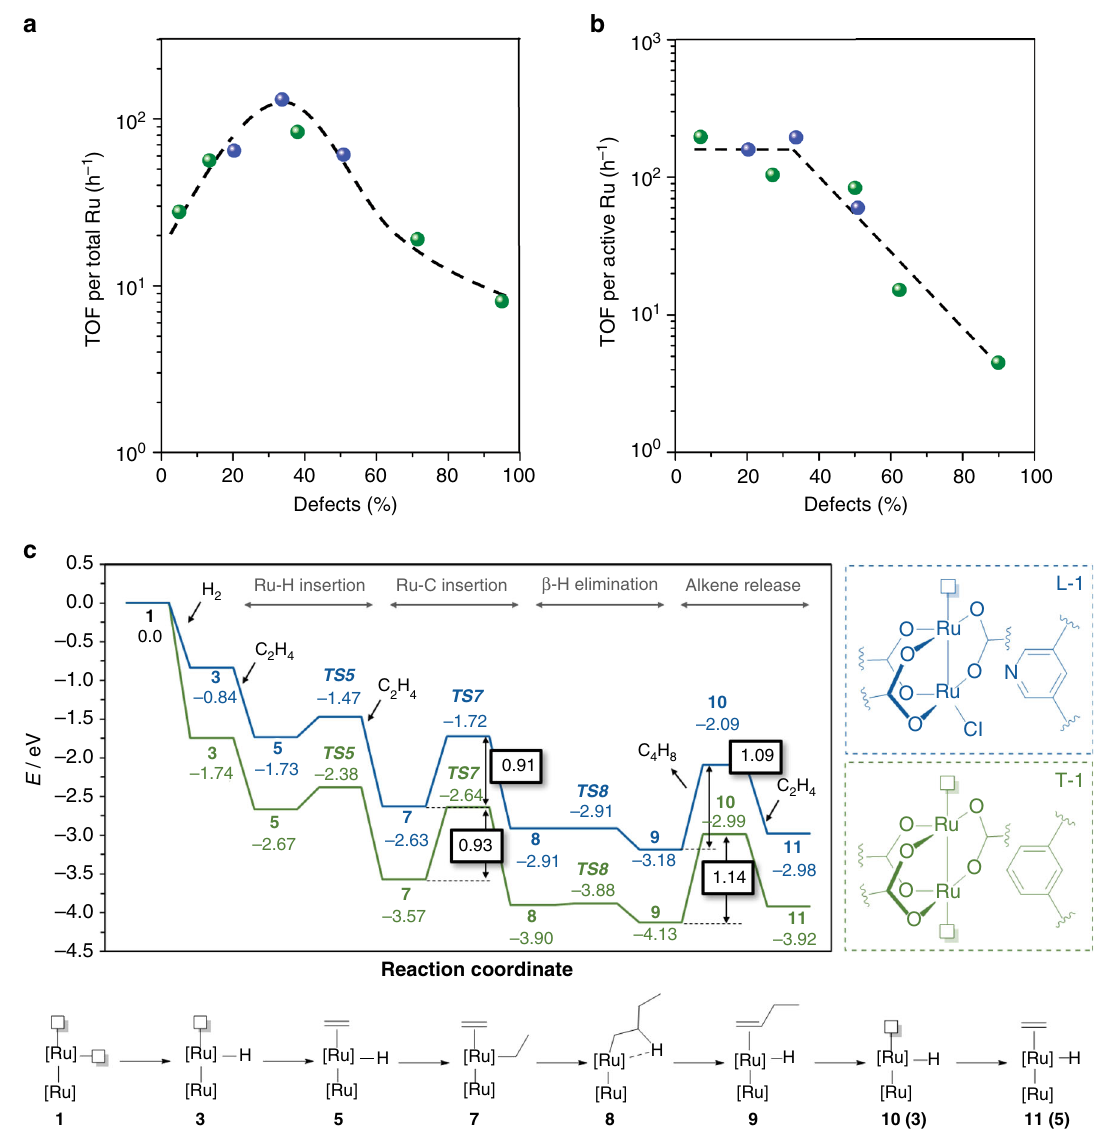
Fig. 4 Effects of ligand- and thermal-engineered defects on catalytic activity. a Turnover frequencies per total Ru as a function of measured defects via ligand (blue) and thermal (green) approaches. b Turnover frequencies per active Ru as a function of measured defects via ligand (blue) and thermal (green) approaches. c Computed reaction mechanism and energy pro fi le for ethylene dimerization via ligand- ( L , blue) and thermal-engineered ( T ,